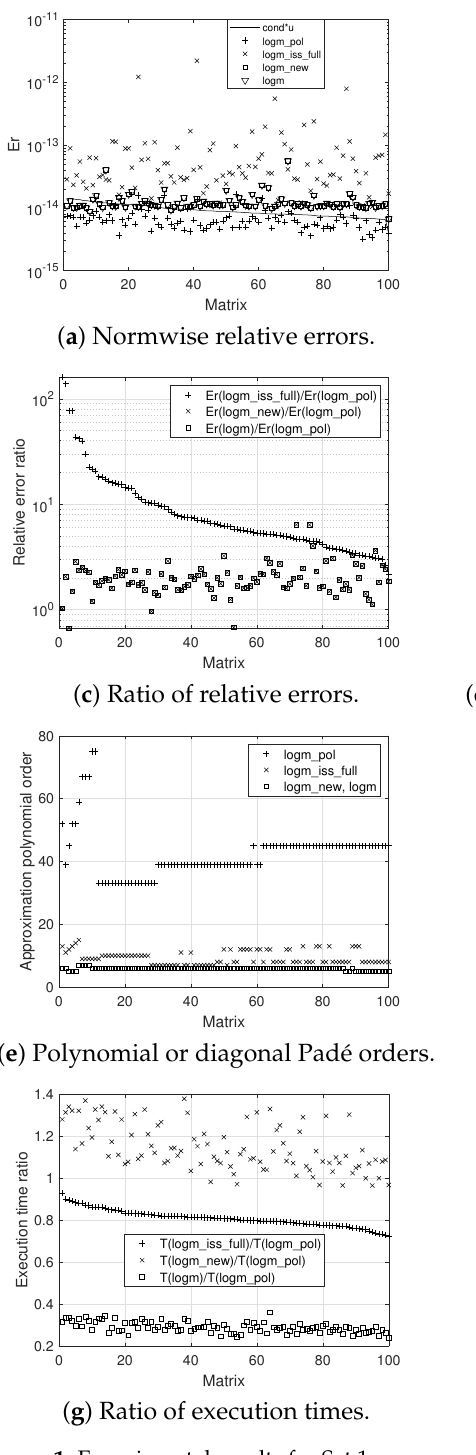
Figure 1. Experimental results for Set